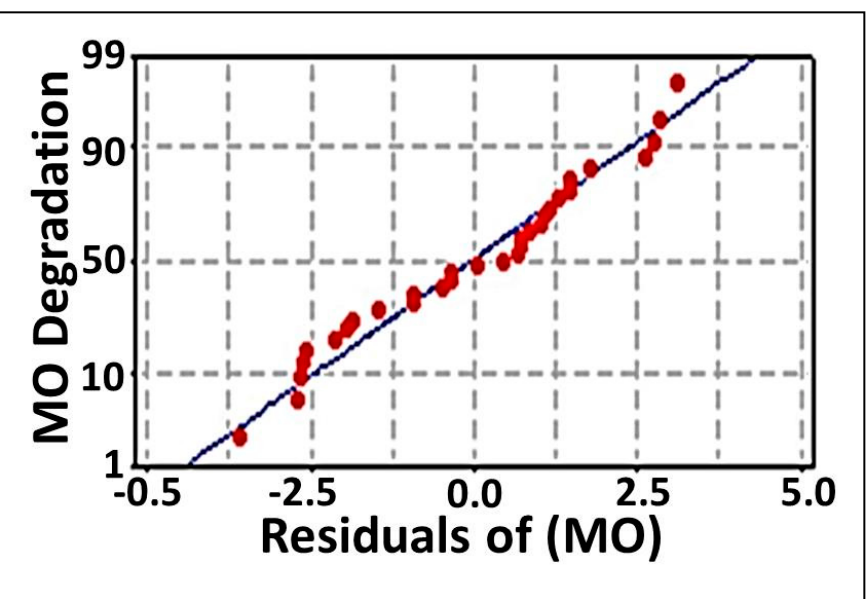
Figure 2. The normal probability plot of the residuals for MO degradation by immobilized consortium determined by the second-order polynomial equation.